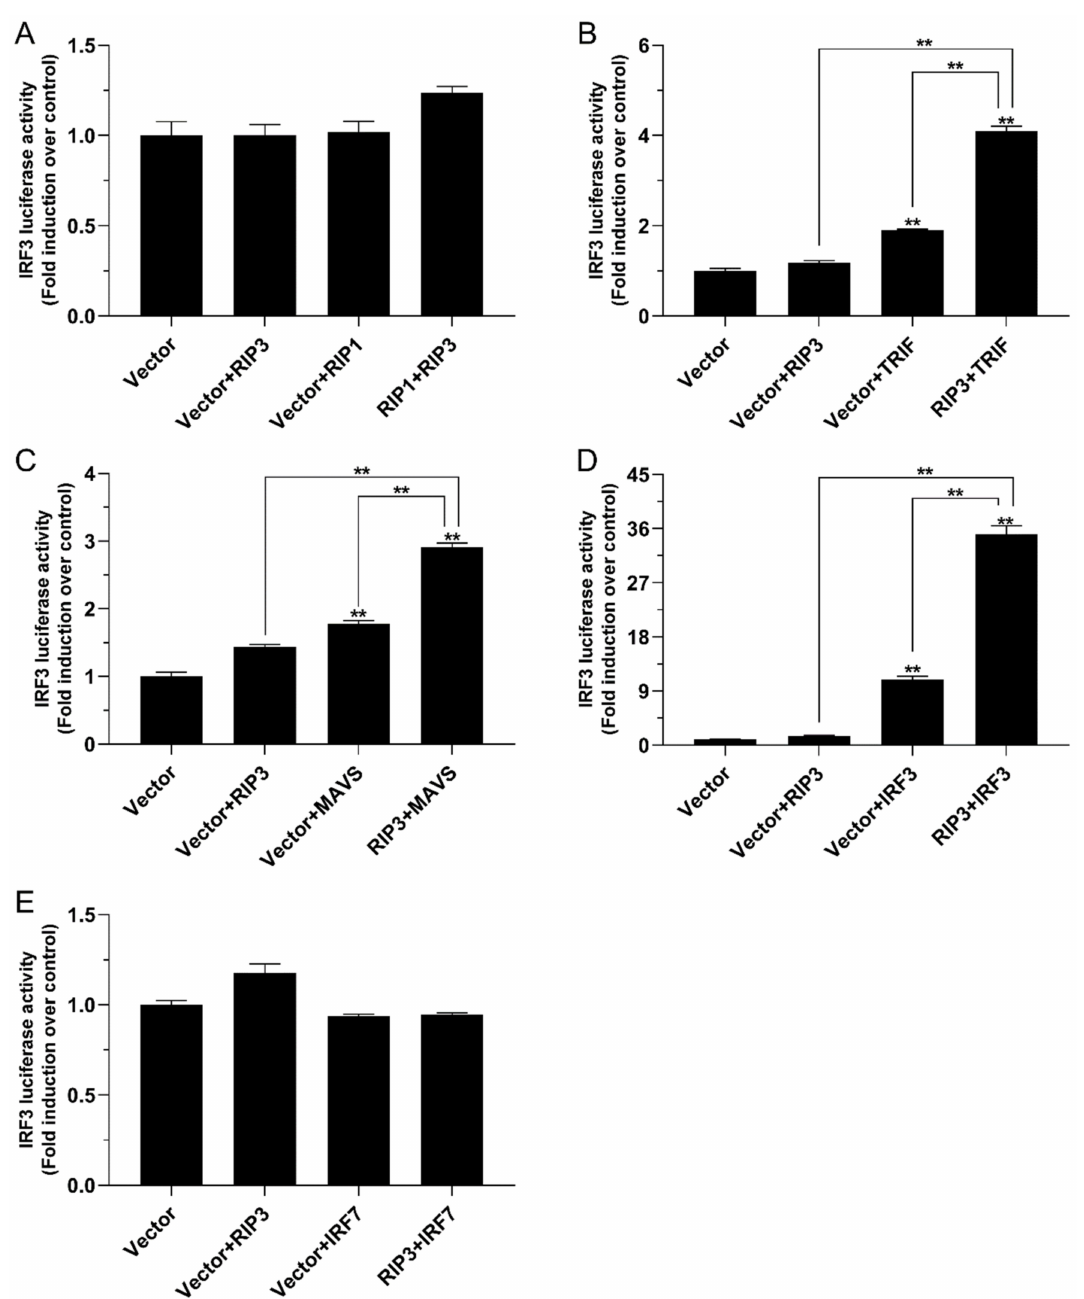
Figure 8. The role of Lc -RIP3 in the regulation of IRF3 signaling. The associations of Lc -RIP3 with Lc -RIP1 ( A ), Lc -TRIF ( B ), Lc -MAVS ( C ), Lc -IRF3 ( D ), and Lc -IRF7 ( E ) in IRF3 promoter activation were analyzed by luciferase reporter assays. HEK 293T cells were co-transfected with 100 ng of pGL4-IRF3-pro and 10 ng of pRL-TK together with 100 ng of pcDNA3.1-RIP3, pcDNA3.1-RIP1, pcDNA3.1-TRIF, pcDNA3.1-MAVS, pcDNA3.1-IRF3, and pcDNA3.1-IRF7 alone or in a combination of two as described above. The luciferase activities were then measured from the cell lysates at 24 h post-transfection. All data were expressed as mean ± SE from three independent experiments with bars representing the SE. ** p <